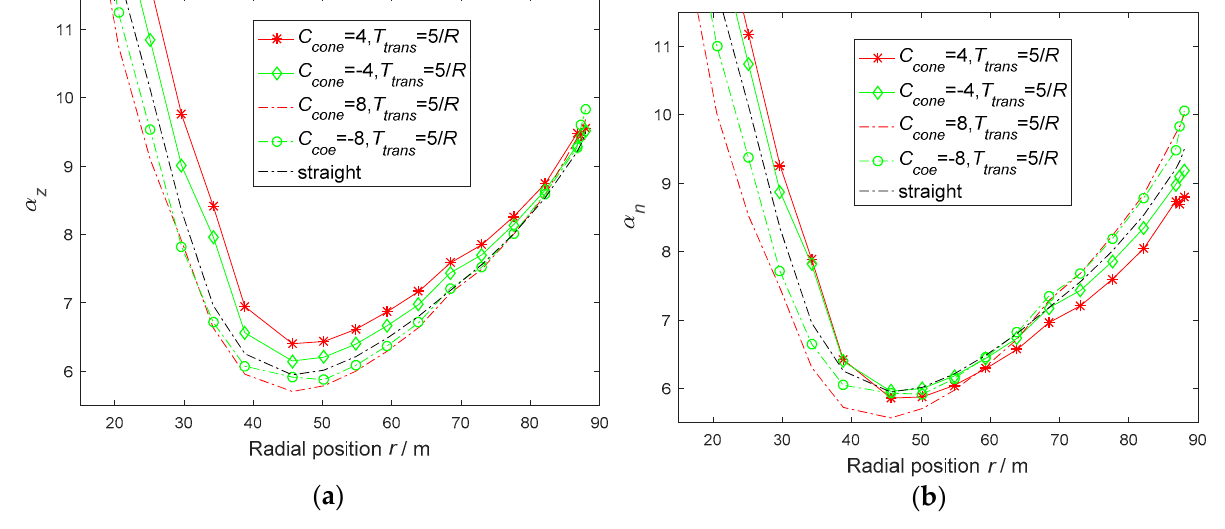
Figure 9. Distributions of angle of attack: ( a ) α z ; ( b ) α n .